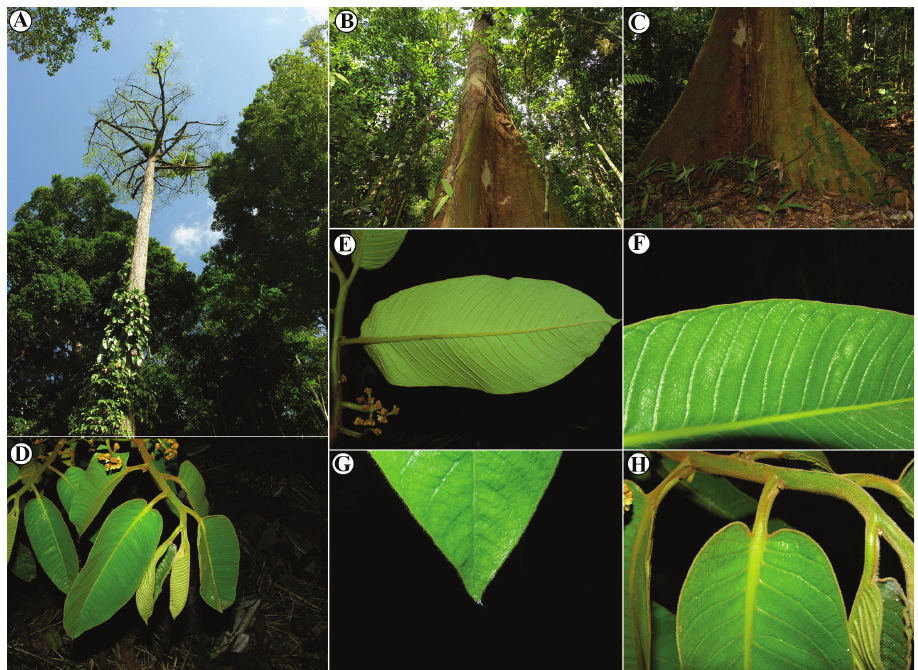
Figure 13. Vegetative characteristics of Virola chrysocarpa A tree showing deciduous nature of the spe- cies B trunk C buttress D branch showing new leaves E leaf blades on abaxial surface F leaf blades on abaxial surface, showing margin detail and venation G leaf apex H new branch and leaf base. Photos by Reinaldo